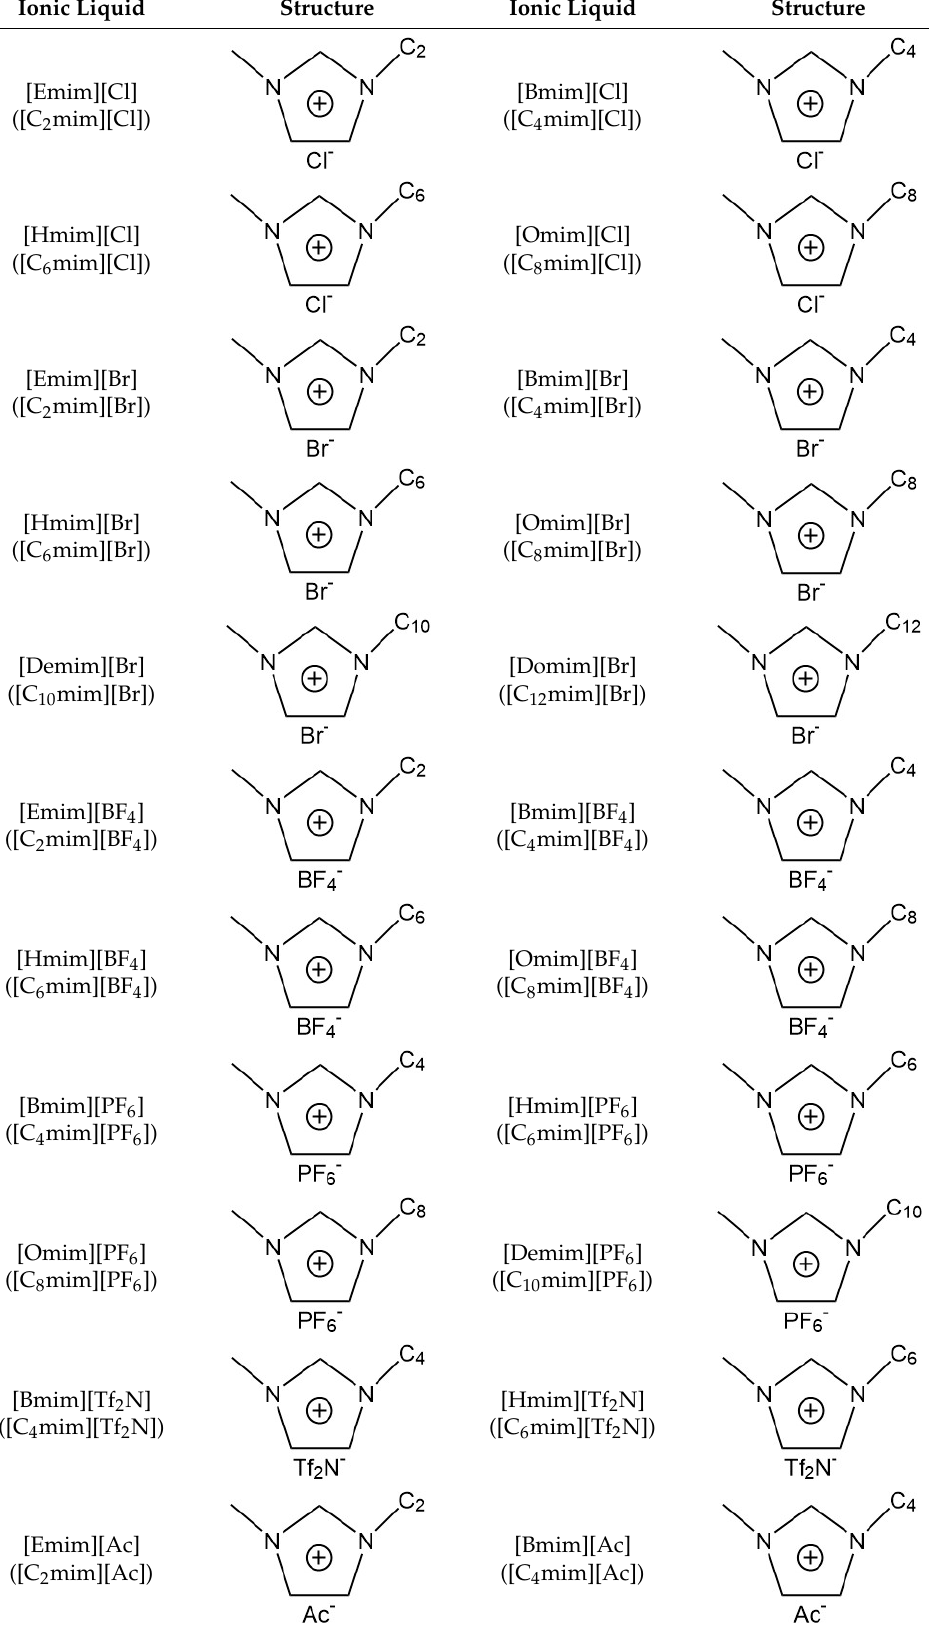
Table 2. The chemical structures of the imidazolium ionic liquids used in the extraction of phytochemicals.